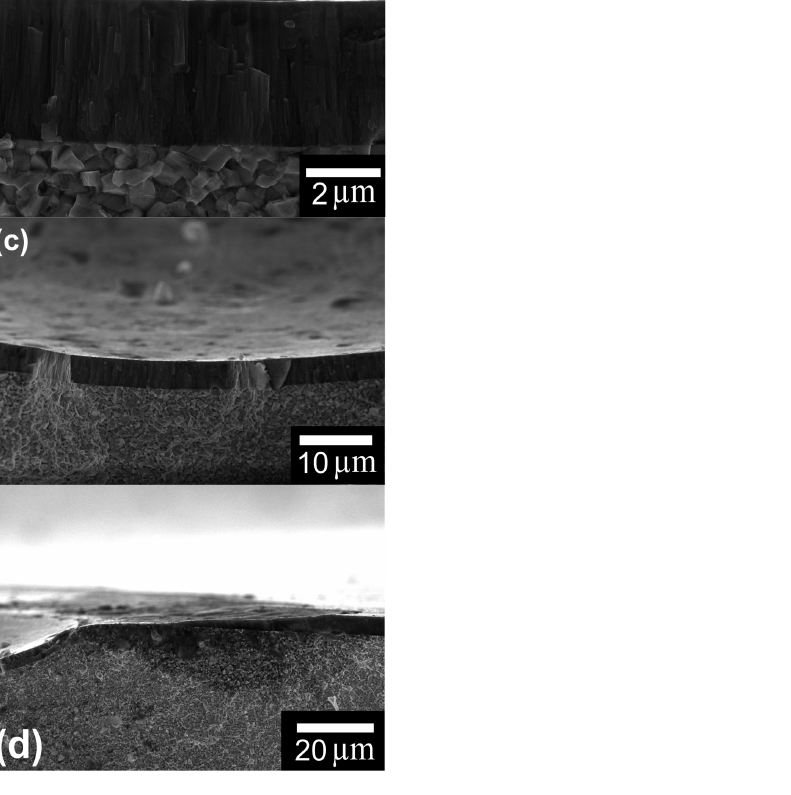
Figure 7. Cross-section of the M1 coating ( a ). Enlarged details of the coating itself ( b ), bottom of the residual impact ( c ), and the impact crater edge ( d ).